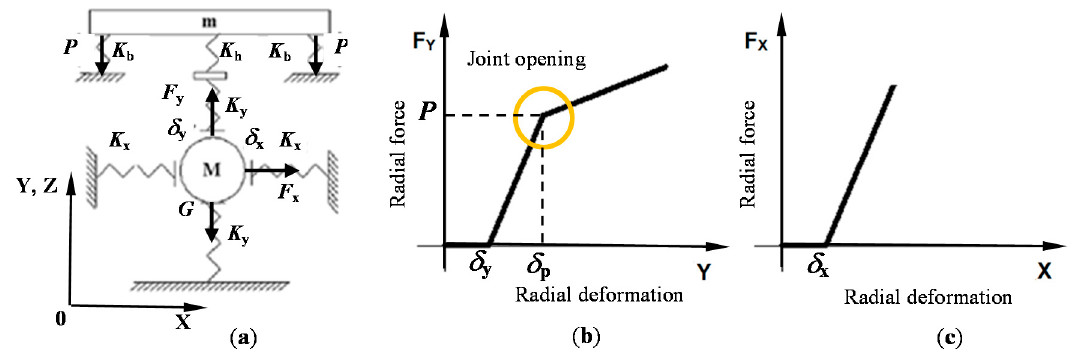
Figure 2. Calculating scheme of the gearbox shaft in the bearing support ( a ); the nonlinear stiffness characteristics of the bearing support with a clearance in vertical ( b ) and horizontal ( c ) direction.